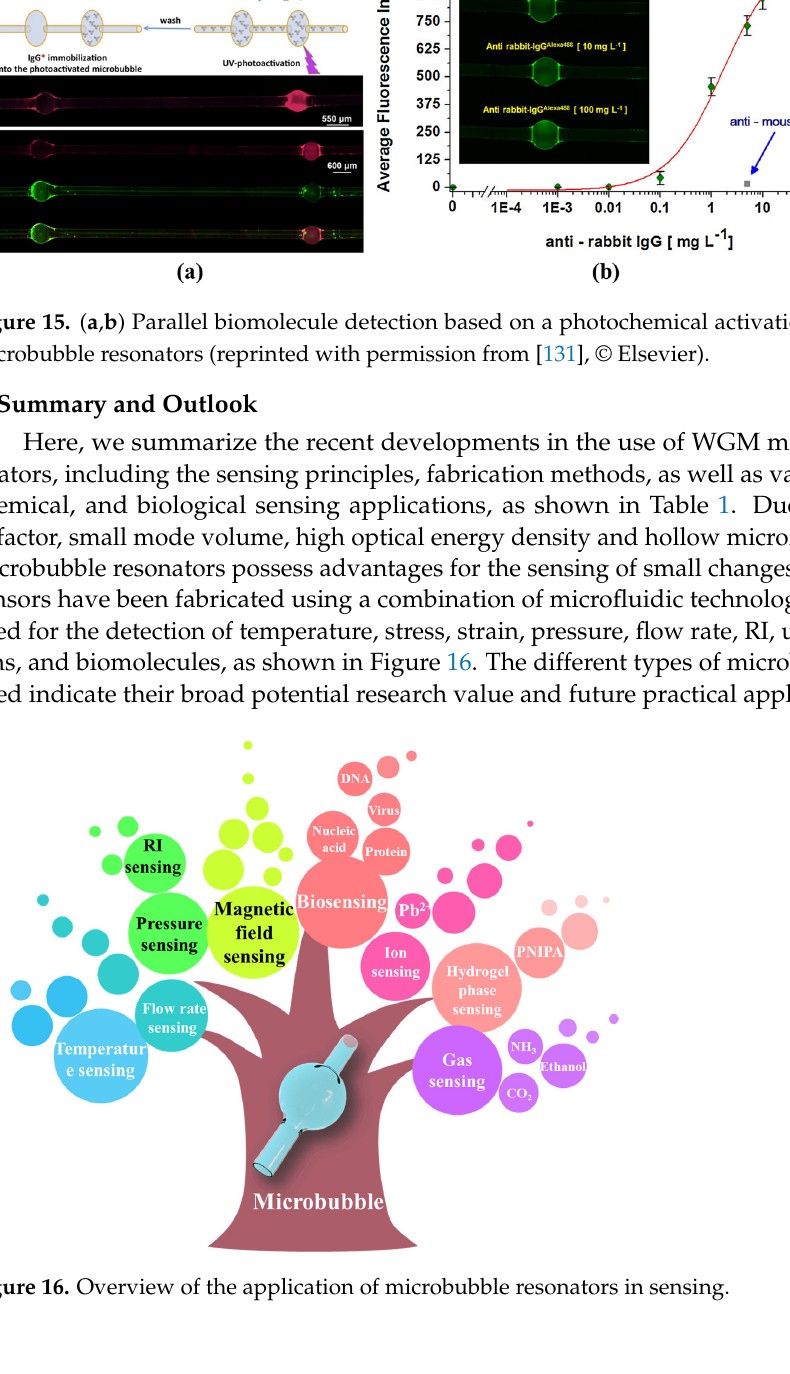
Figure 16. Overview of the application of microbubble resonators in sensing.